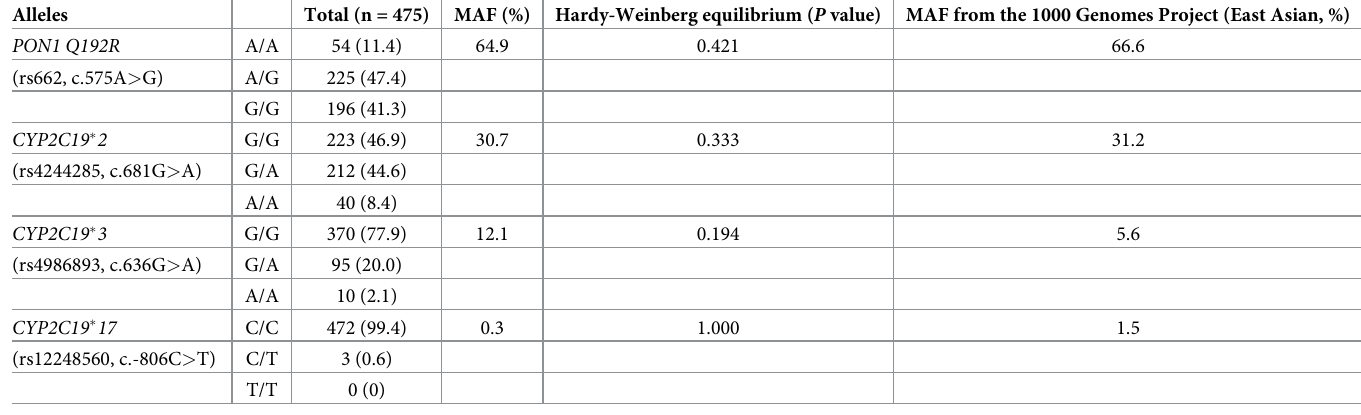
Table 1. Genotype distribution among the study population.